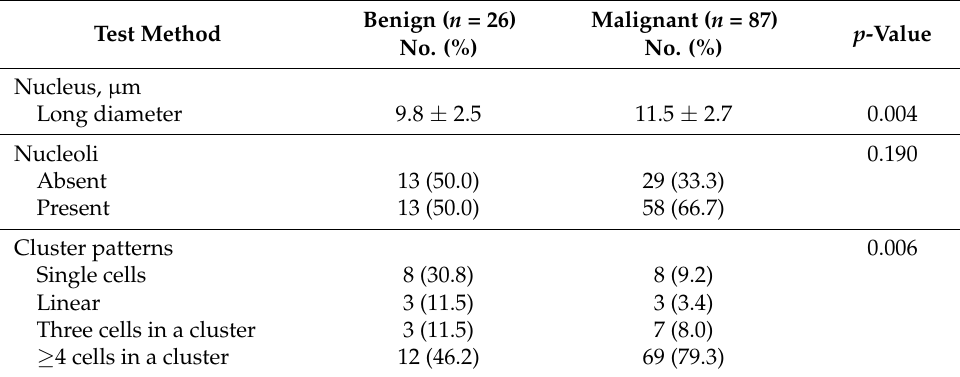
Table 2. Benign and malignant